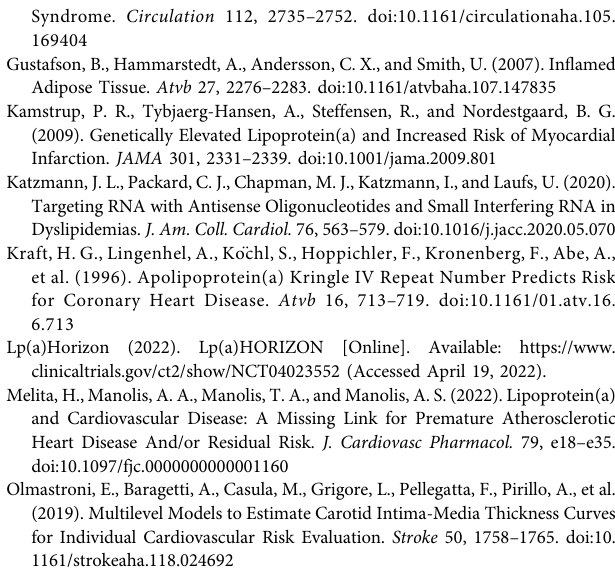
Supplementary Figure S1 | Box plot illustrating Lp(a) distribution across the study groups. Black circles represent the outlier values as identi fi ed by the iterative Grubb ’ s